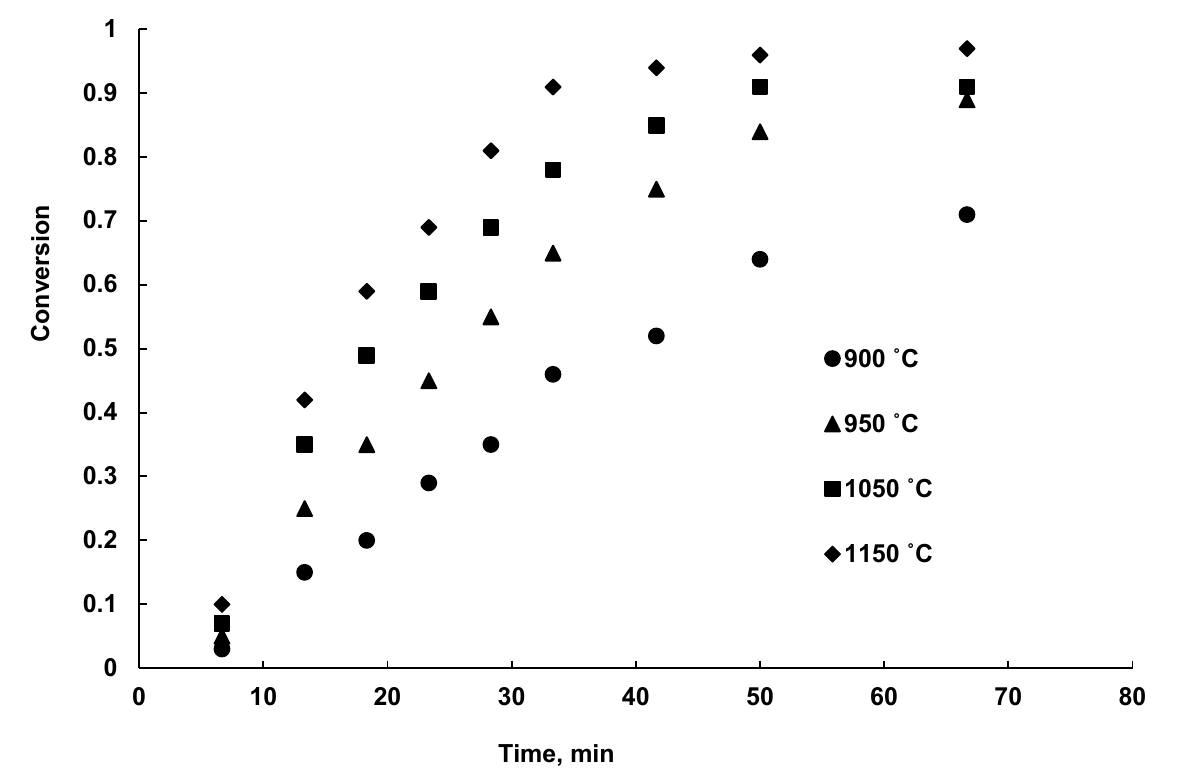
Figure 3. Conversion-time plots for the reduction of barite compacted samples (zone A; see Figure 1) with brown coal.